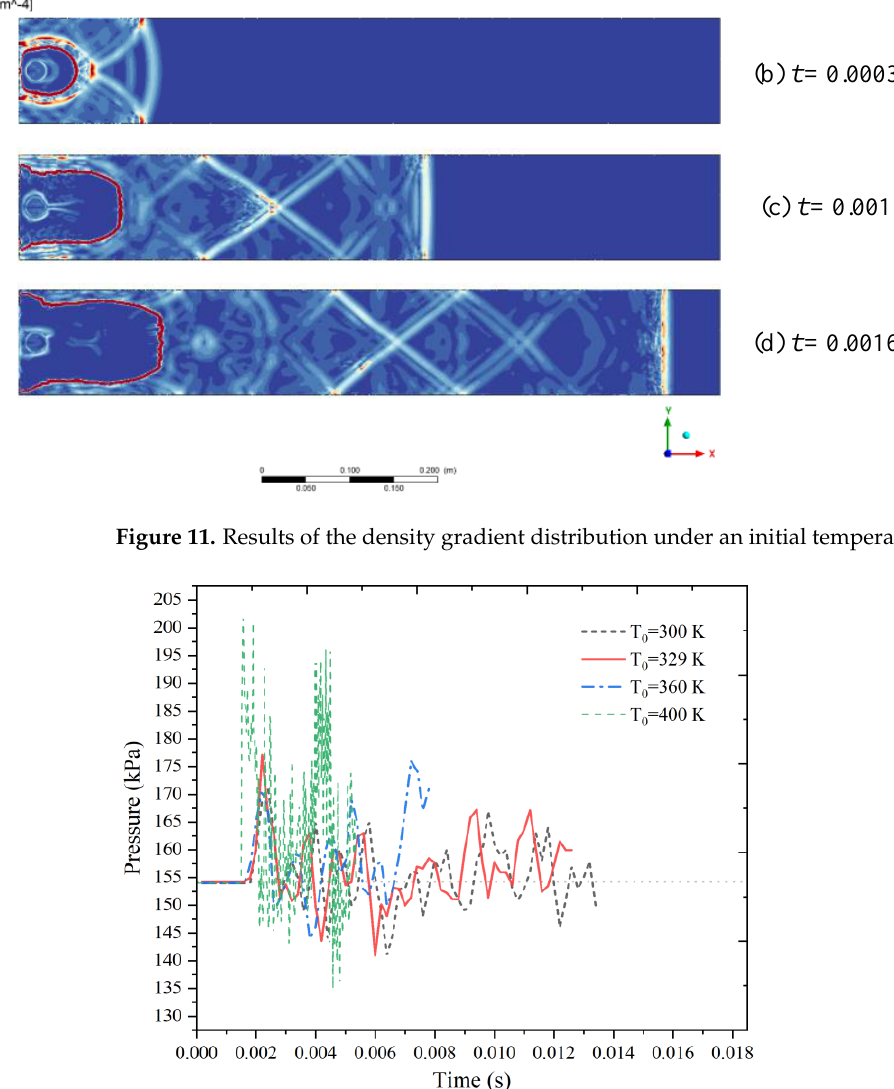
Figure 12. Results of the pressure measured at x = 0.7 m under different initial temperatures.